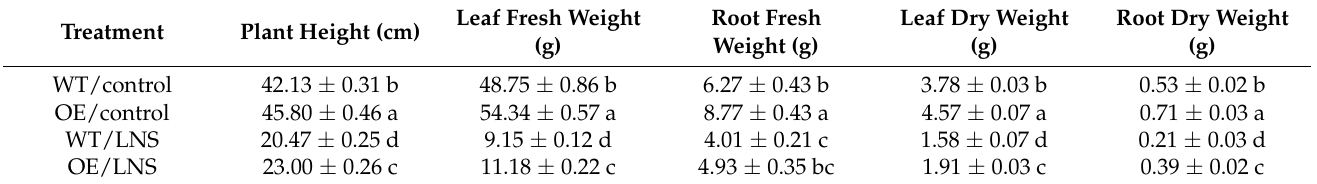
Table 1. Growth indexes of tomato seedlings 12 days after low nutrient stress treatment.